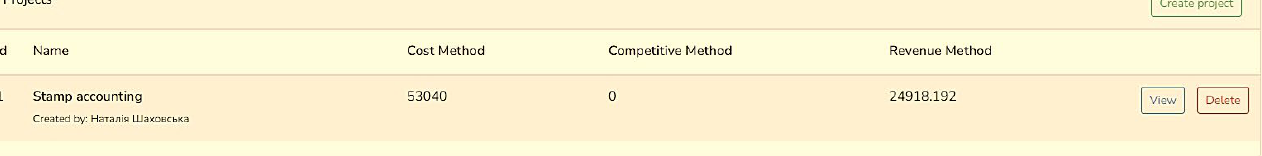
Figure 12. Web page for R&D product cost estimation.